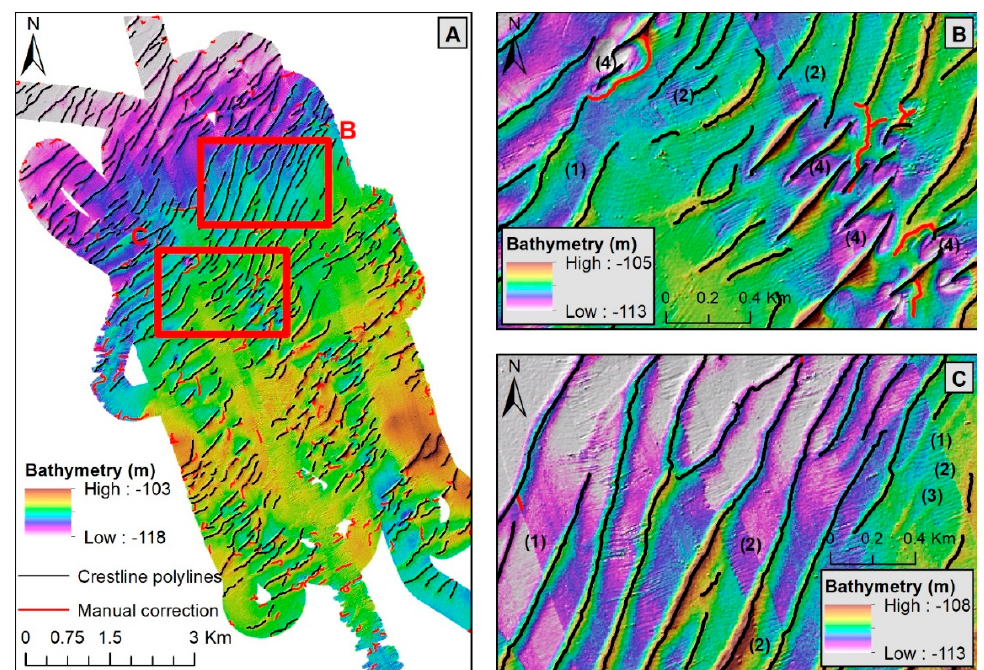
Figure 10. Map of the crestline polylines obtained by using the automated workflow ( A ). Manual corrections (i.e., deleting polylines) were locally required in the vicinity of data artefacts or seabed scours ( B , C ). (1) DEM acquisition corridor artefacts, (2) swath artefacts (perpendicular to acquisition corridors), (3) bedforms below minimum height threshold and (4) Seabed depressions/scours.